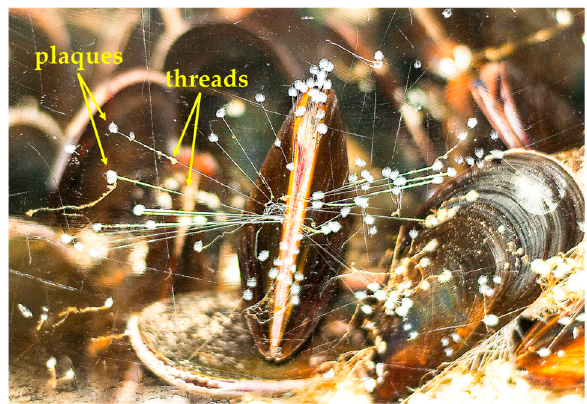
Figure 1. Marine mussel adhered to a glass wall of an aquarium tank. The byssal adhesive assemblies consist of adhesive plaques and threads which remain tethered to the byssal retractor muscles inside the shells.